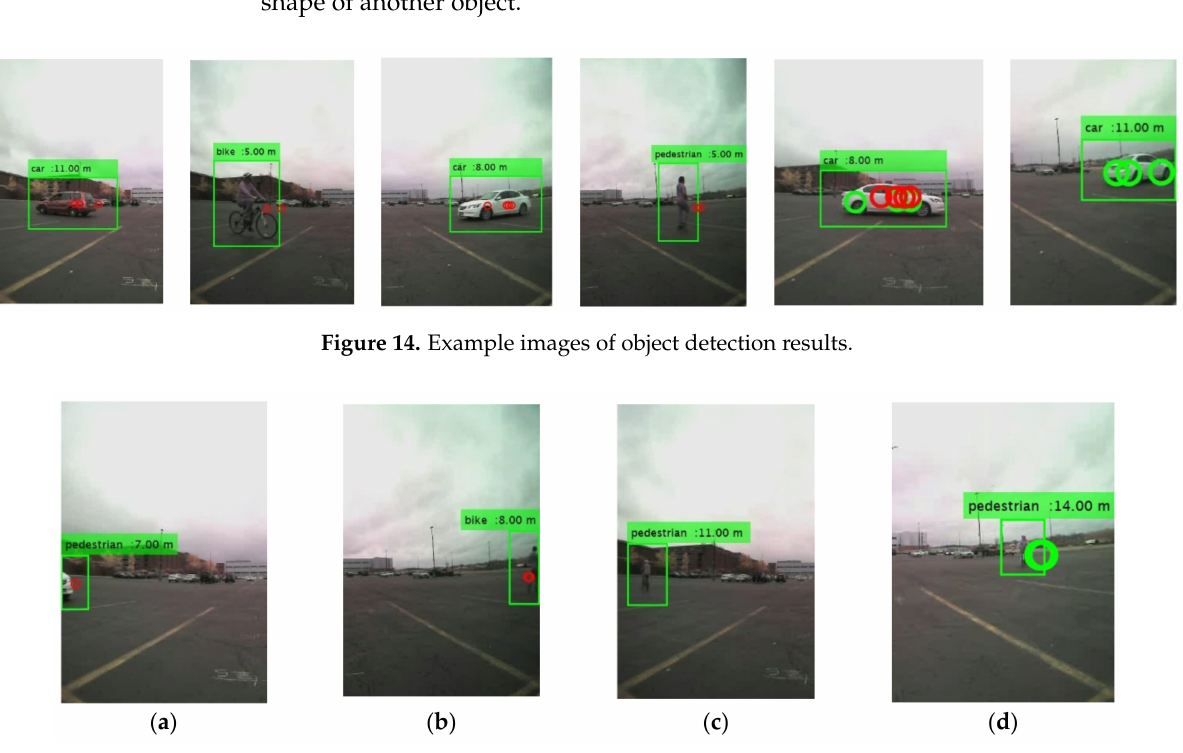
Figure 15. False classification examples: ( a , b ) false classification because the shape of the objects is partially presented; ( c , d ) false classification because the shape of the bike looks similar with the shape of